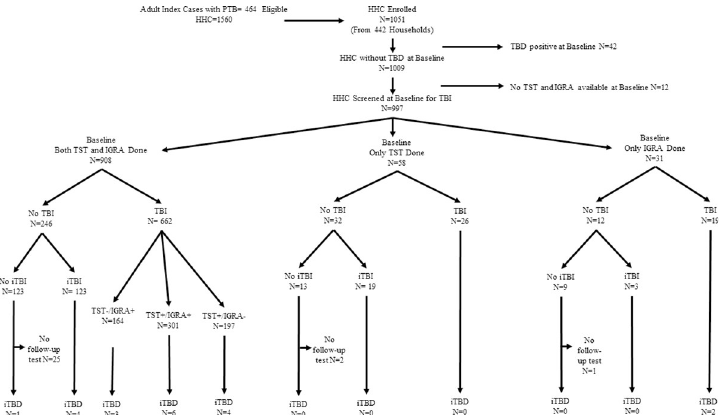
Fig 1. Screening of household contacts of adult pulmonary TB patients in India. Flowchart depicts the screening of household contacts (HHC) of adult pulmonary TB (PTB) patients in India, and shows that 1051 HHC enrolled in the study, 997 with no baseline TB disease (TBD) and with at least one baseline test for TB infection (TBI) available, were included in the final analysis. These 997 asymptomatic HHC were classified as those with and without baseline TBI (baseline TBI was defined as TST � 5 mm and/or IGRA � 0.35 IU/ml). HHC without baseline TBI were further classified as those with and without incident TBI (iTBI was defined as TST � 5 mm and/or IGRA � 0.35 IU/ml